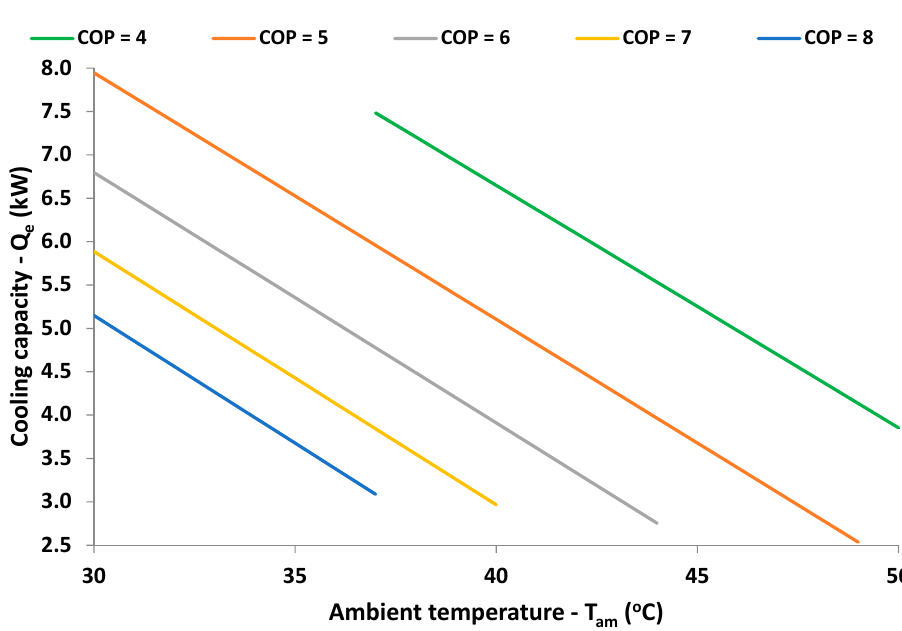
Figure 15. Rotational speed for different ambient temperatures and cooling capacities ( T ind = 25 °C and 1000 rpm < n < 4000 rpm).